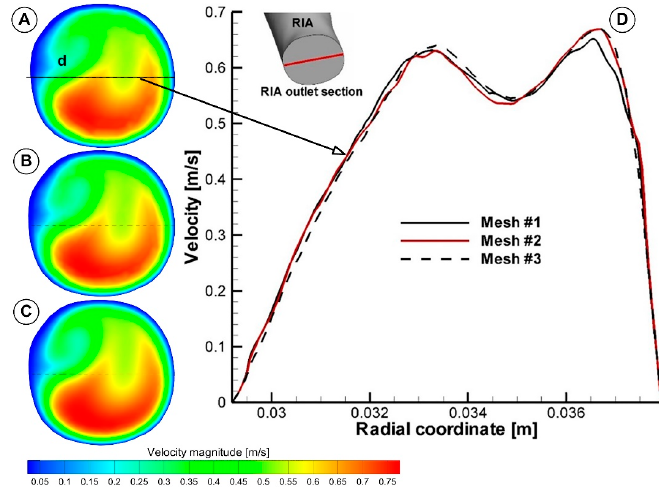
Figure 9. Mesh sensitivity test for the velocity profile associated with the right iliac artery (RIA) diameter in the outlet section ( D ). “d” diameter of the exit section of RIA. ( A ) coarse mesh (mesh#1); ( B ) medium mesh (mesh#2), and ( C ) fine mesh (mesh#3). ( A – C ) shows the velocity magnitude contour in the outlet section of the RIA.